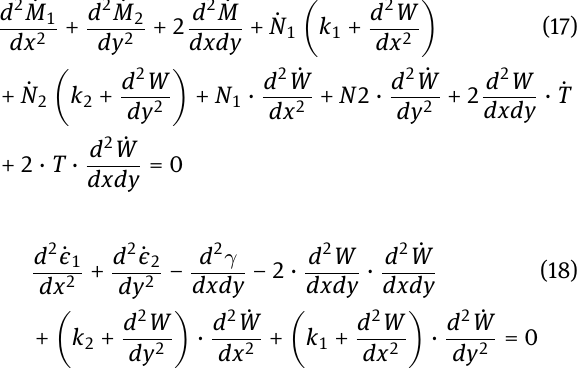
Like any physically nonlinear theory of plasticity prob- lem, this problem has no direct solution. To solve it, the method of variable elasticity parameters is used [30], with recalculation at each step of the approximation of the stiff- ness characteristics D i , B i and a solution to the system of 98 algebraic